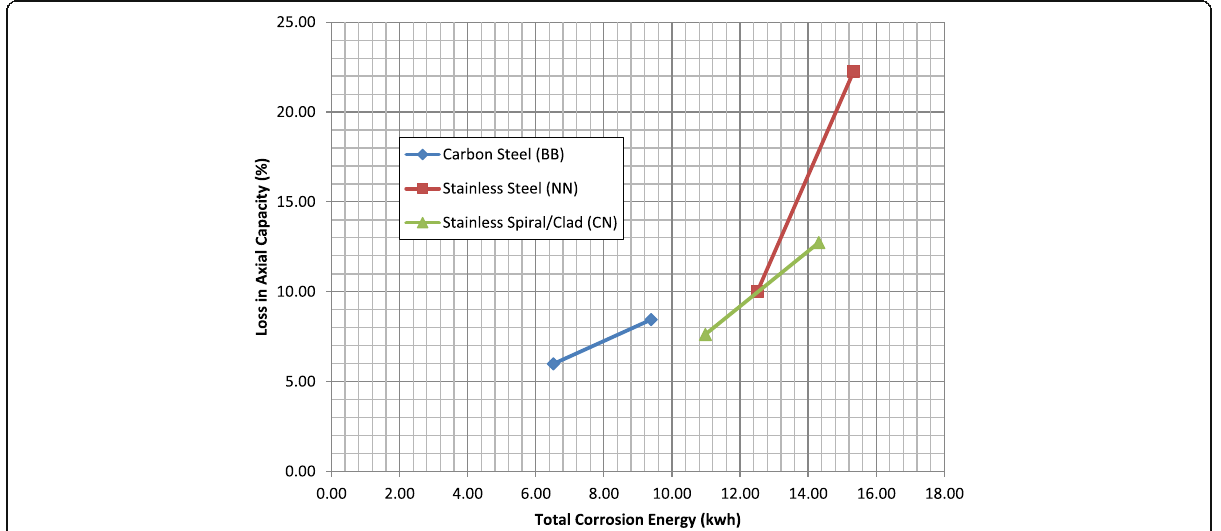
Fig. 15 Axial compression capacity loss in terms of total corrosion energy